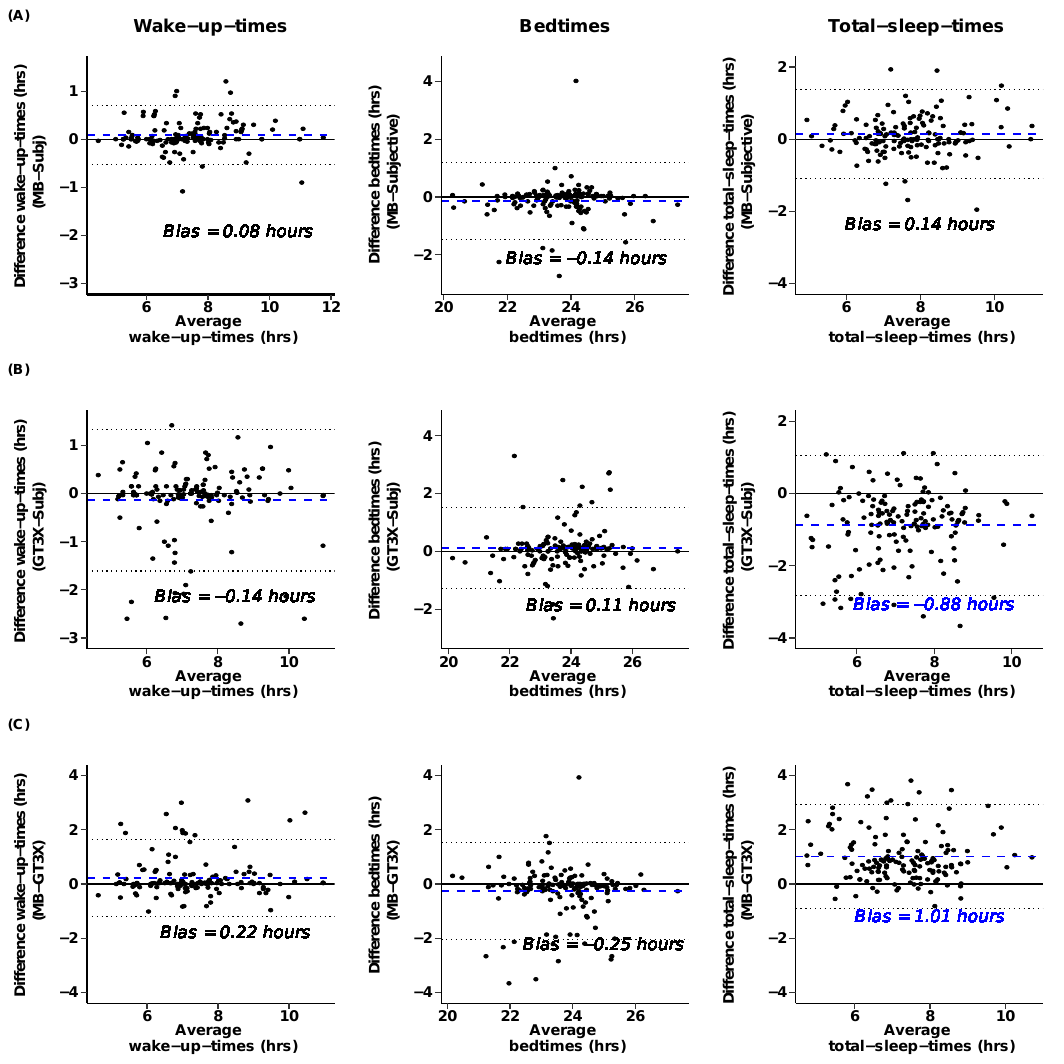
Figure 2. Agreement between the objective and subjective sleep measures: MB vs. subjective ( A ), GT3X vs.subjective ( B ), and the two objective methods MB and GT3X ( C ) as visualized by Bland–Altman plots for wake-up-times, bedtimes, and total-sleep-time. Note the high bias and increased deviations between the GT3X and both subjective and MB total-sleep- times. The dashed lines represent the mean difference (i.e., bias) between the two measurements. The dotted blue lines mark the 95% CI limits of the mean difference, and the black solid line represents the point of equality (where the difference between the two devices is equal to